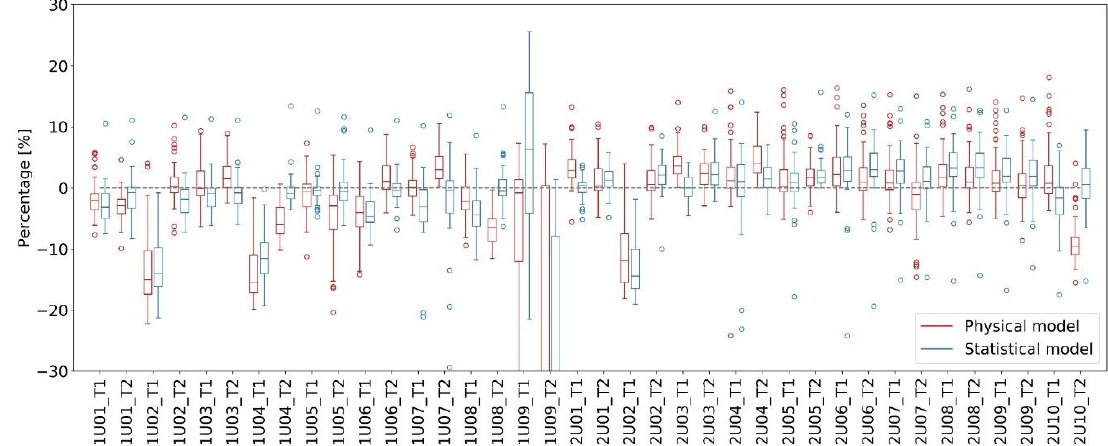
Figure 11. Boxplot of REPI for all MPPTs using physical models and statistical models shown in the range ( − 30%, 30%).